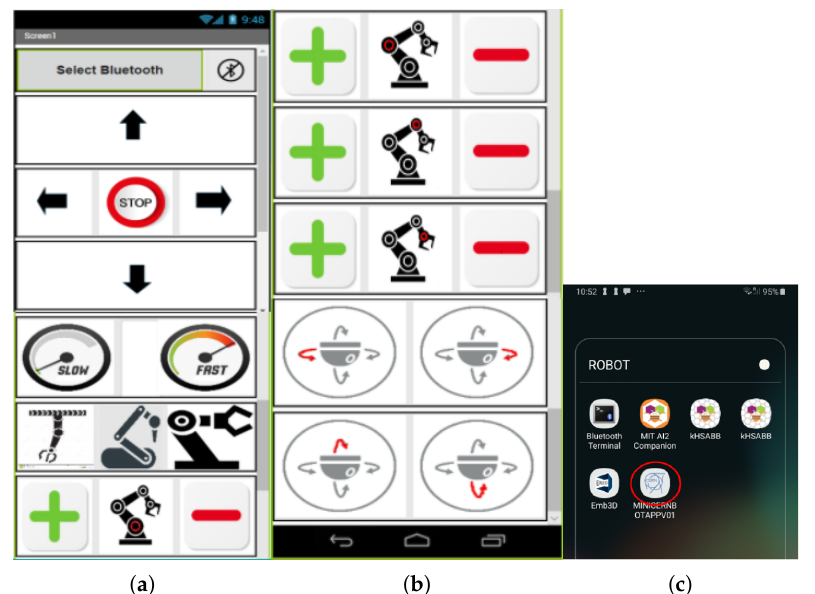
Figure 14. Example of Android User interface created by a high-school student ( a ) base controls; ( b ) arm controls; ( c ) Android Application Logo defined by the